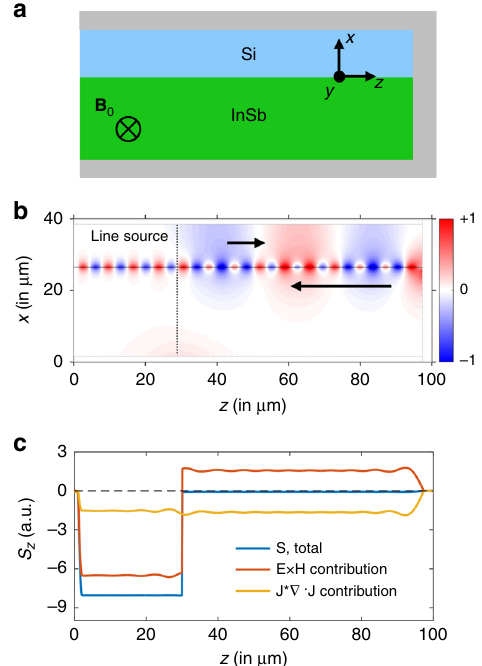
Fig. 3 Numerical simulation of a truncated waveguide using the hydrodynamic model. A fi nite-difference frequency-domain (FDFD) algorithm is used to obtain the numerical results, at ω = 0.7 ω p . a The structure as considered in ref. 18 . b Field pro fi le of H z generated by the indicated line source, clearly depicting a backward propagating mode with a signi fi cantly smaller wavevector than the forward propagating mode. c A fi nite Poynting fl ux in the backward direction relative to the line source, and a zero Poynting fl ux forward owing to the PEC to the right. The blue curve is the total Poynting vector from Eq. (9), while the red and yellow curve are its electromagnetic and kinetic terms, respectively, from Eq.